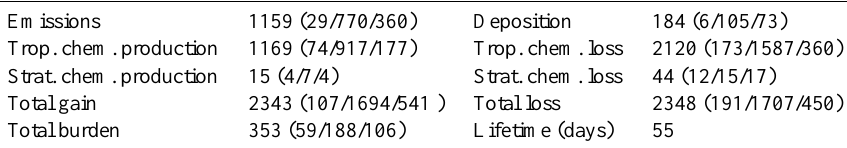
Table 9. The global CO budget for the year 2006 given in Tg CO yr − 1 . The distribution for the SH extra-tropics/tropics/NH extra-tropics are given in parentheses. The stratospheric region is here defined as all levels where monthly mean O 3 > 150ppbv. The difference in total gain and loss implies a net trend in CO of ∼